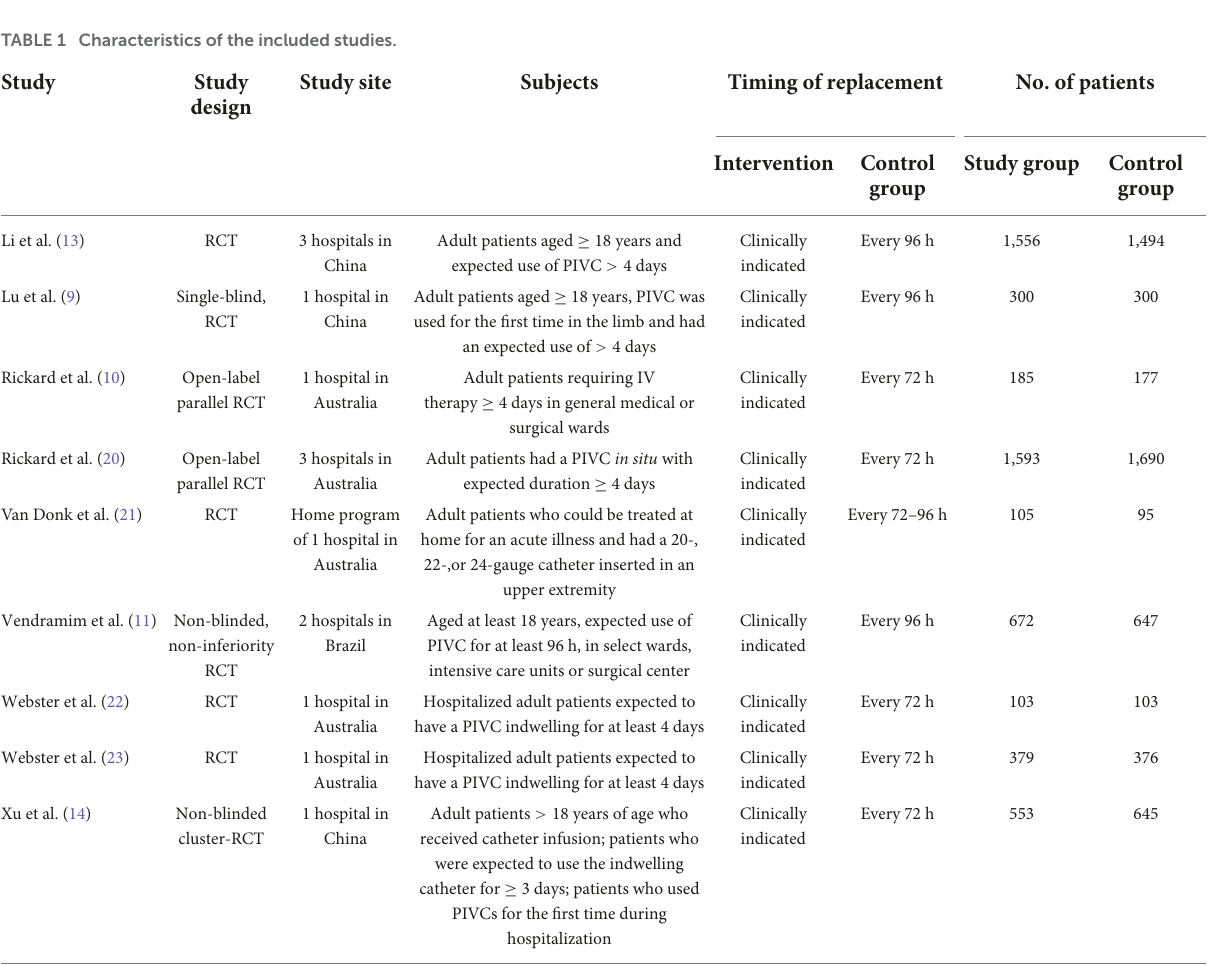
TABLE 1 Characteristics of the included